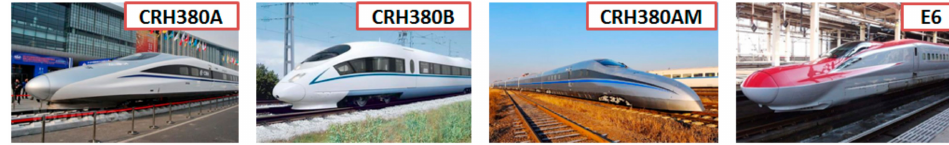
Figure 2. Typical streamlined structures of high-speed trains’